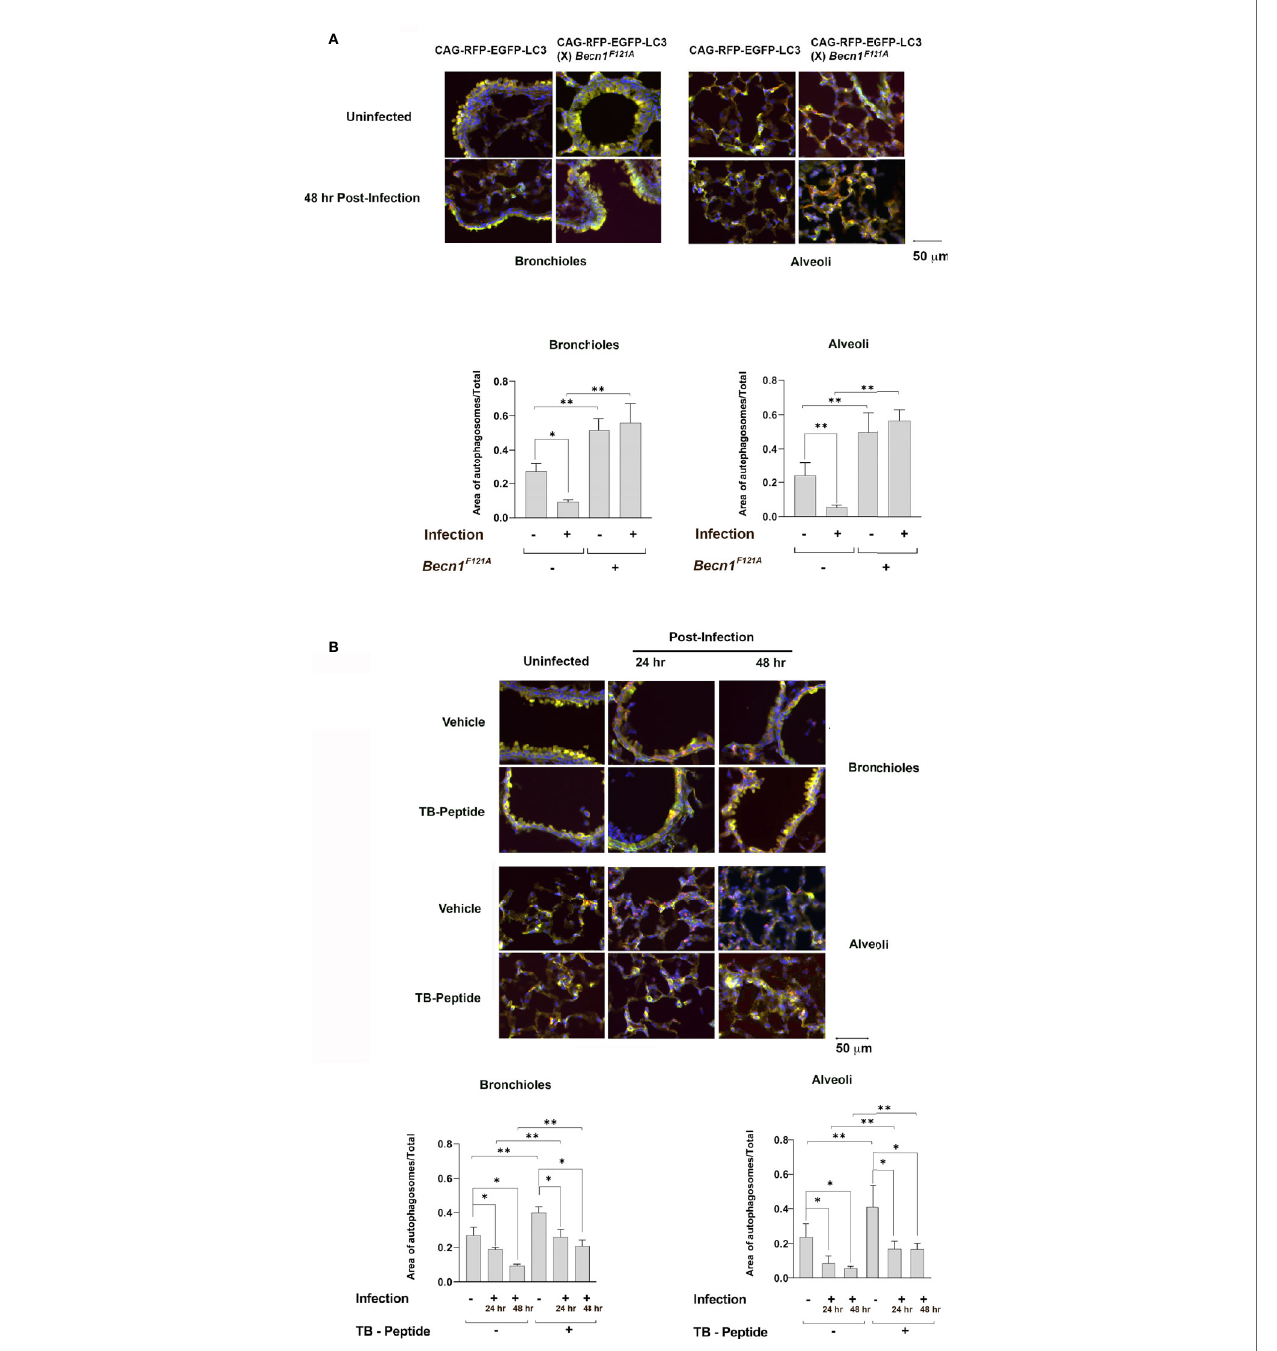
FIGURE 1 | Lung autophagy in response to pneumonia-induced sepsis and the effects of Beclin-1 activation. (A) Autophagy reporter CAG-RFP-EGFP-LC3 mice or mice of CAG-RFP-EGFP-LC3 (X) Becn1 F121A/F121A were given septic infection of K.pneumoniae (3X10 7 CFU/mouse) or PBS (uninfected) via intubation. Lung tissue samples were harvested 48 h post infection, and lung tissue slides were evaluated under fl uorescence microscopy. Neutral autophagosomes, shown in yellow, allow emissions from both EGFP (green) and RFP (red). Acid autolysosomes, shown in red, are due to signals from RPF. DAPI in blue indicates nucleic acid staining. (B) CAG-RFP-EGFP-LC3 mice receiving K. pneumoniae infection or PBS (uninfected) were given TB-peptide (16.5 mg/kg, i.p.) or PBS control vehicle 1 h post- infection. Lung tissue samples were harvested 24 and 48 h post infection, and lung tissue slides were evaluated under fl uorescence microscope as described in (A) In both (A, B) autophagosome areas were quanti fi ed as ratios to the total area examined. Images are representative of n ≥ 5 animals per group and ten random high-power fi elds were examined per animal. All values are means ± SEM. Signi fi cant differences are shown as * for uninfected vs . infected, ** for WT vs . Becn1 F121A/F121A (A) or for TB-peptide treated vs . untreated (B) ( p < 0.05, student